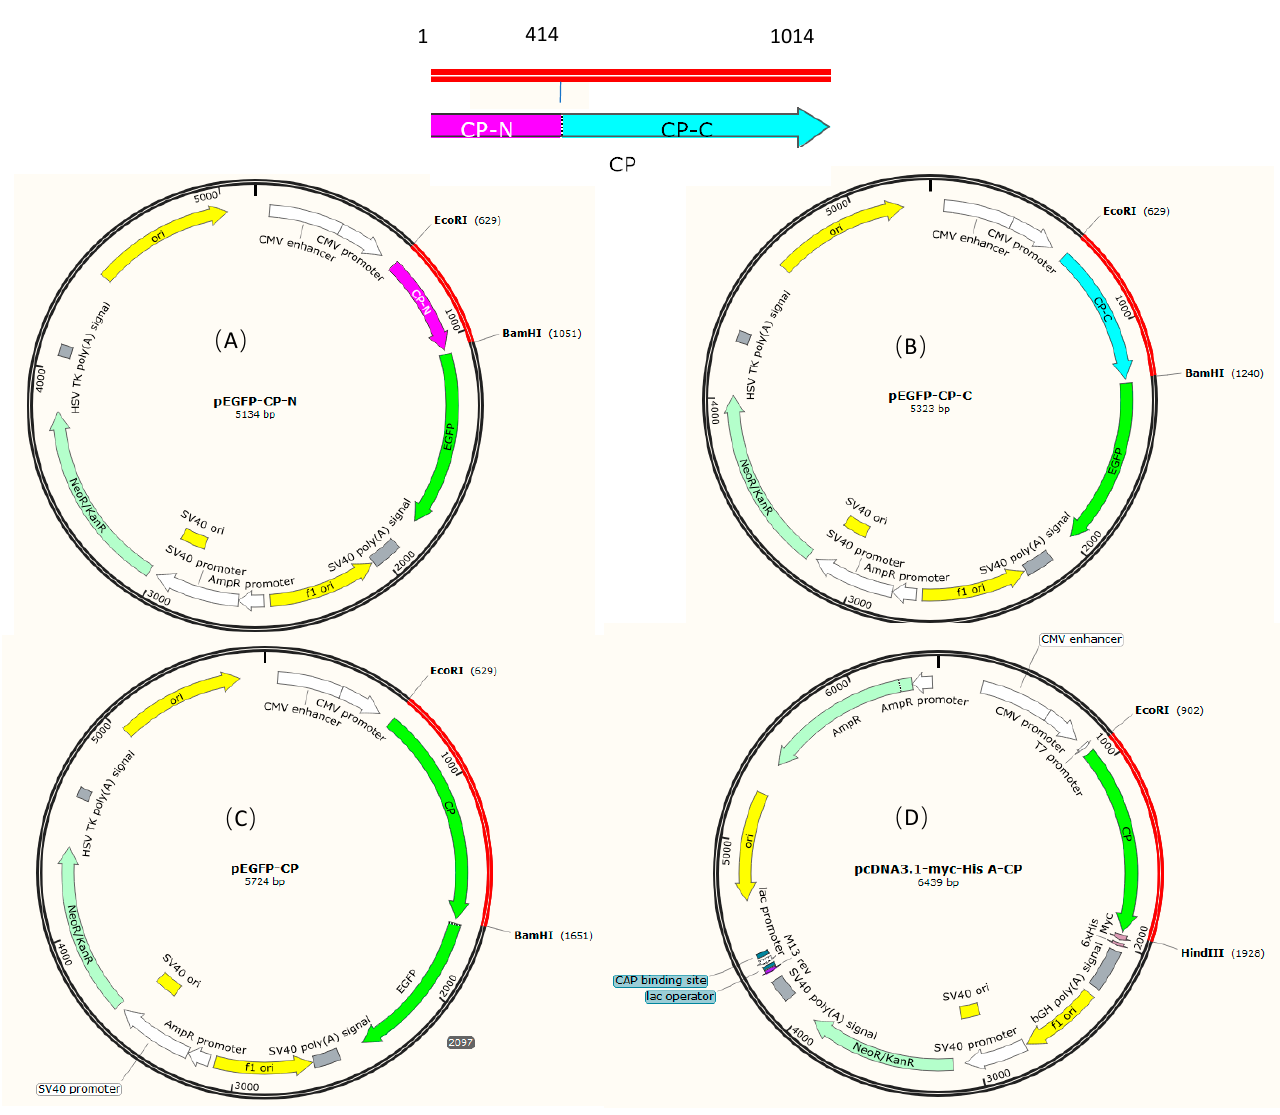
Figure 1. Plasmid construction of BFNNV capsid. ( A ) Map of pEGFP-CP-N. The N-terminal of capsid protein is colored pink; ( B ) Map of pEGFP-CP-C. The C-terminal of capsid protein is colored blue; ( C ) Map of pEGFP-CP with the tag of EGFP; ( D ) Map of pcDNA3.1-CP with tags of Myc and His.